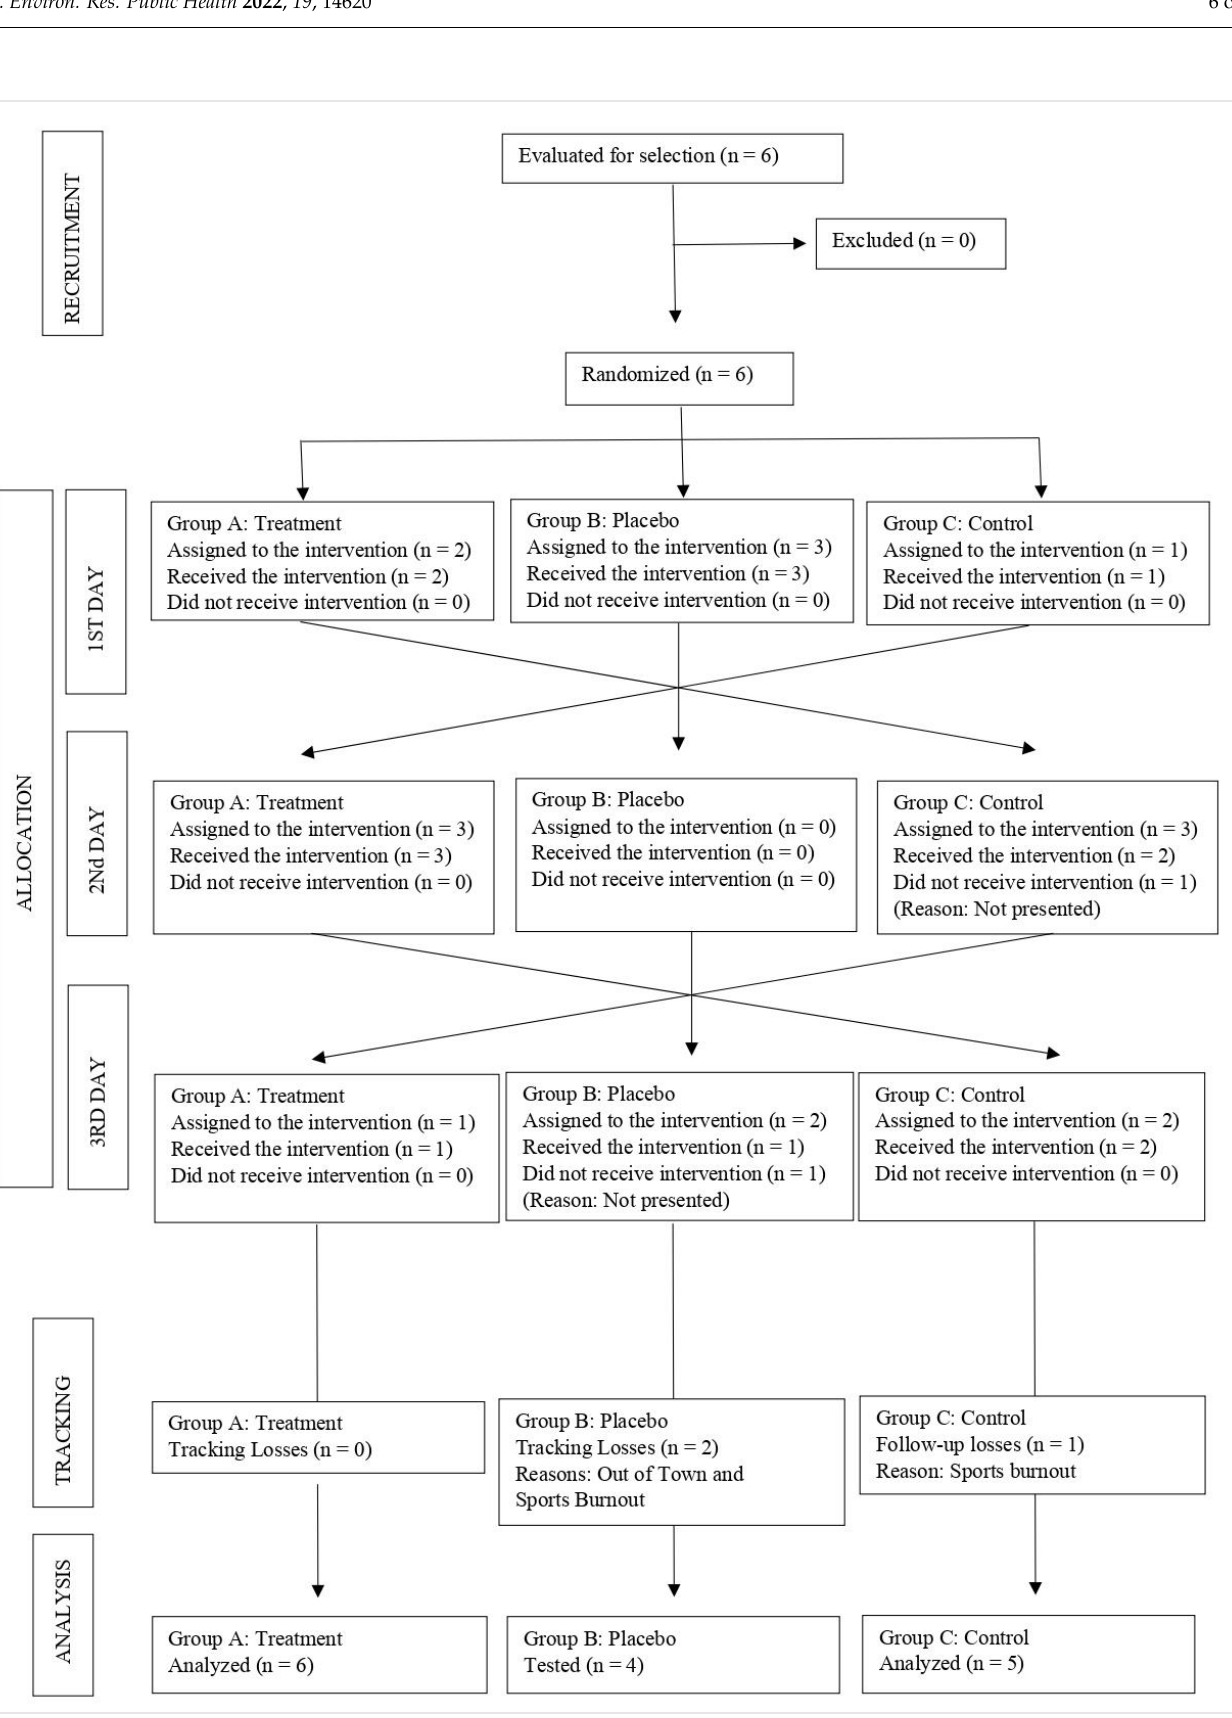
Figure 3. CONSORT flowchart. For each group, the number of participants who were randomized; received the intended treatment, and analyzed for the primary outcome. Source: Own elaboration.